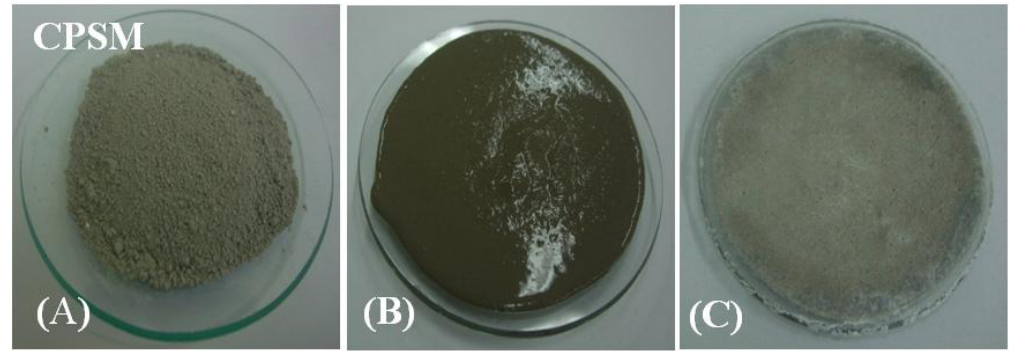
Figure 1. The photos of before, during and after hydration process for the same sample. ( A ) before hydration; ( B ) during hydration; ( C ) after